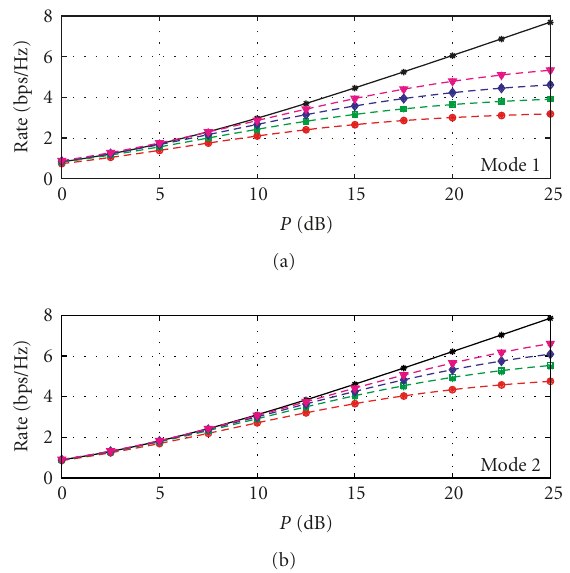
Figure 3: Achievable rate per beam for two-antenna mode 1 and 2 in the presence of Rayleigh fading and constant Tx power. Solid curves refer to TDMA-RR when total Tx power is normalized to P/ 2. Dashed curves refer to achievable rate per beam for spatial multiplexing with SIR CQI and di ff erent number of users reporting identical CDI ( n = 1,2,4,8). In all cases, point values (“ ∗ ”) were simulated to verify the analytical results.